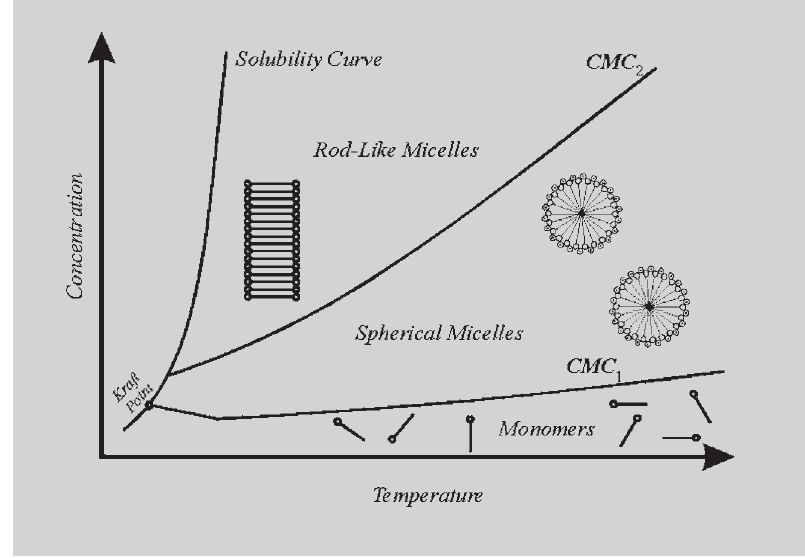
Figure 1: Schematic phase diagram for surfactant solutions